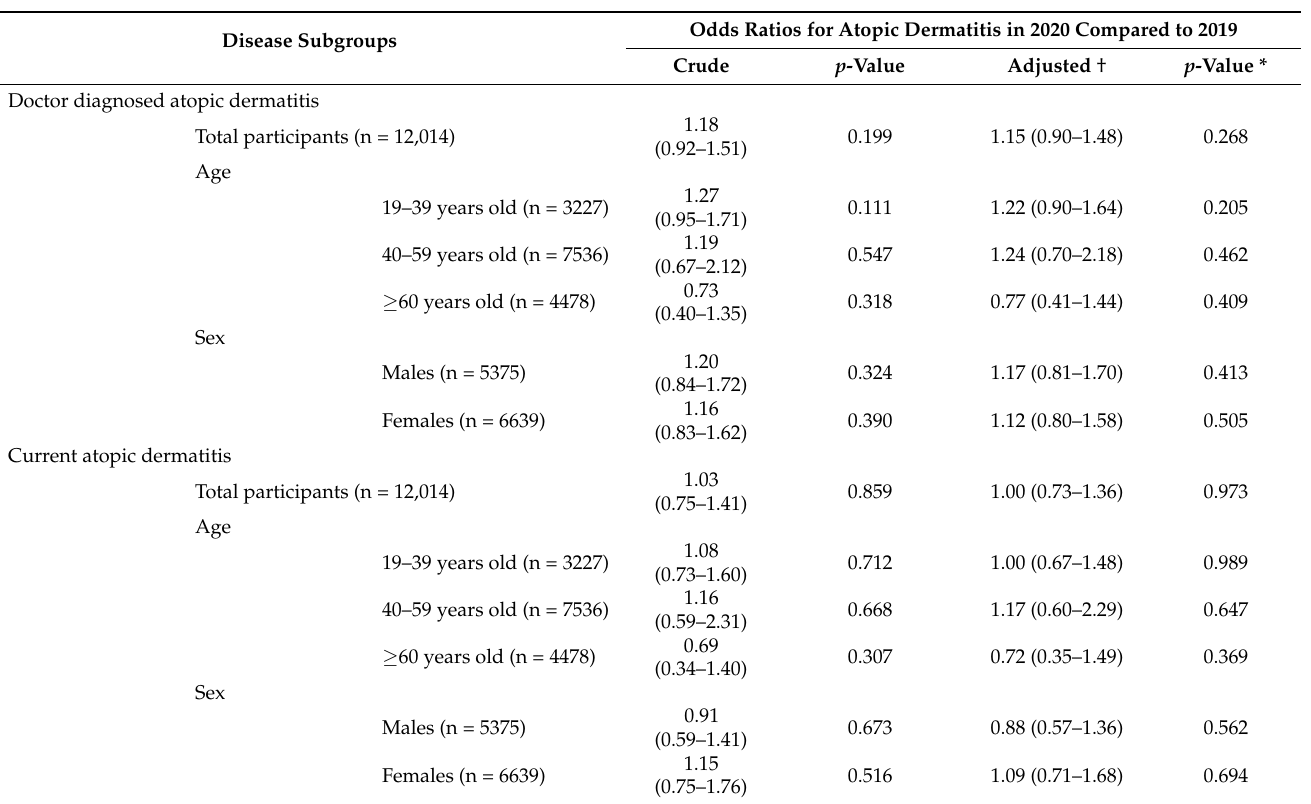
Table 3. Odds ratios (95% confidence intervals) for atopic dermatitis (doctor diagnosed atopic dermatitis, current atopic dermatitis) in 2020 compared to 2019 with subgroup analyses according to age and